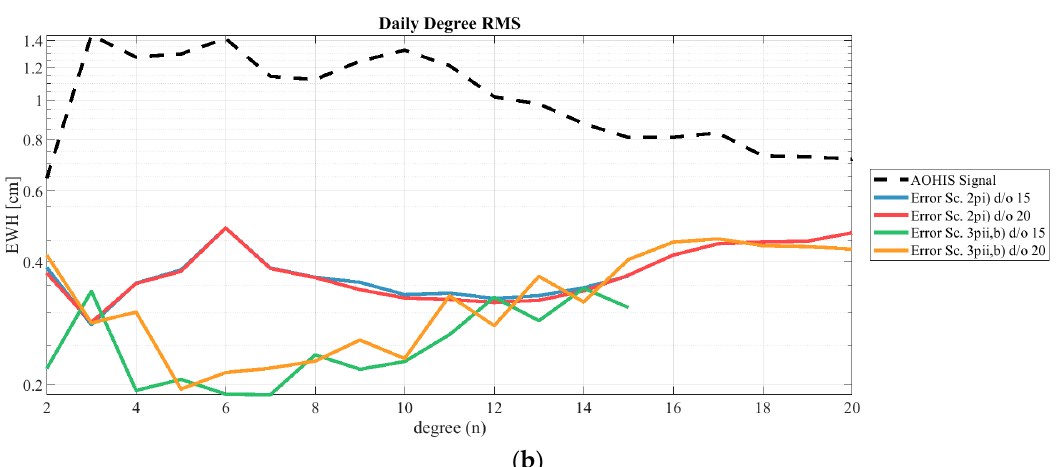
Figure 7 . Degree RMS of scenario 2pi and 3pii,b. a) Seven-day solution degree RMS with daily Figure 7. Degree RMS of scenario 2pi and 3pii,b. ( a ) Seven-day solution degree RMS with daily parametrization up to d/o 15 and 20. b) Degree RMS of daily solutions with parametrization up to d/o parametrization up to d / o 15 and 20. ( b ) Degree RMS of daily solutions with parametrization up to d / o 15 and 20. 15 and